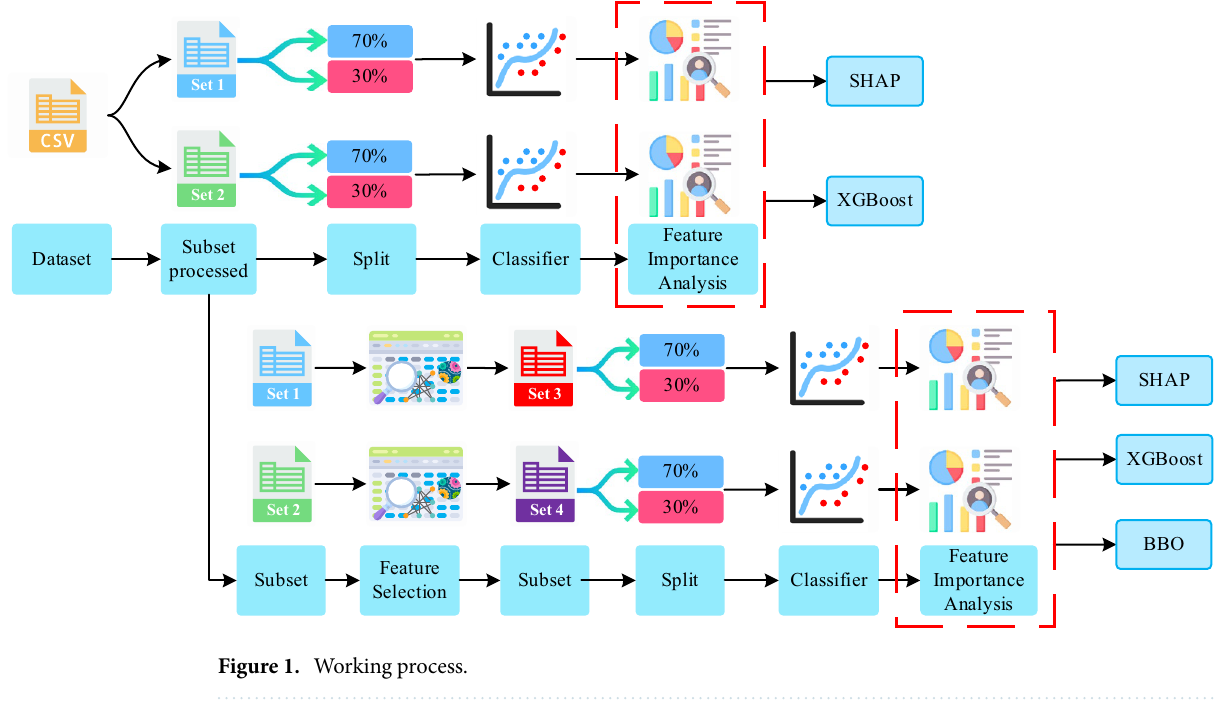
Figure 1. Working